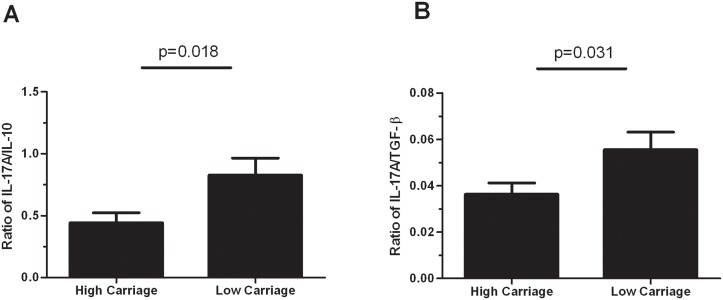
Th17/Treg balance is different in children with low and high pneumococcal carriage densities.The Th17/Treg axis is shown for IL-17A/IL-10 (A) and IL-17A/TGF-β (B) Bars represent mean ± SEM. Comparisons were done using an unpaired Student’s test.